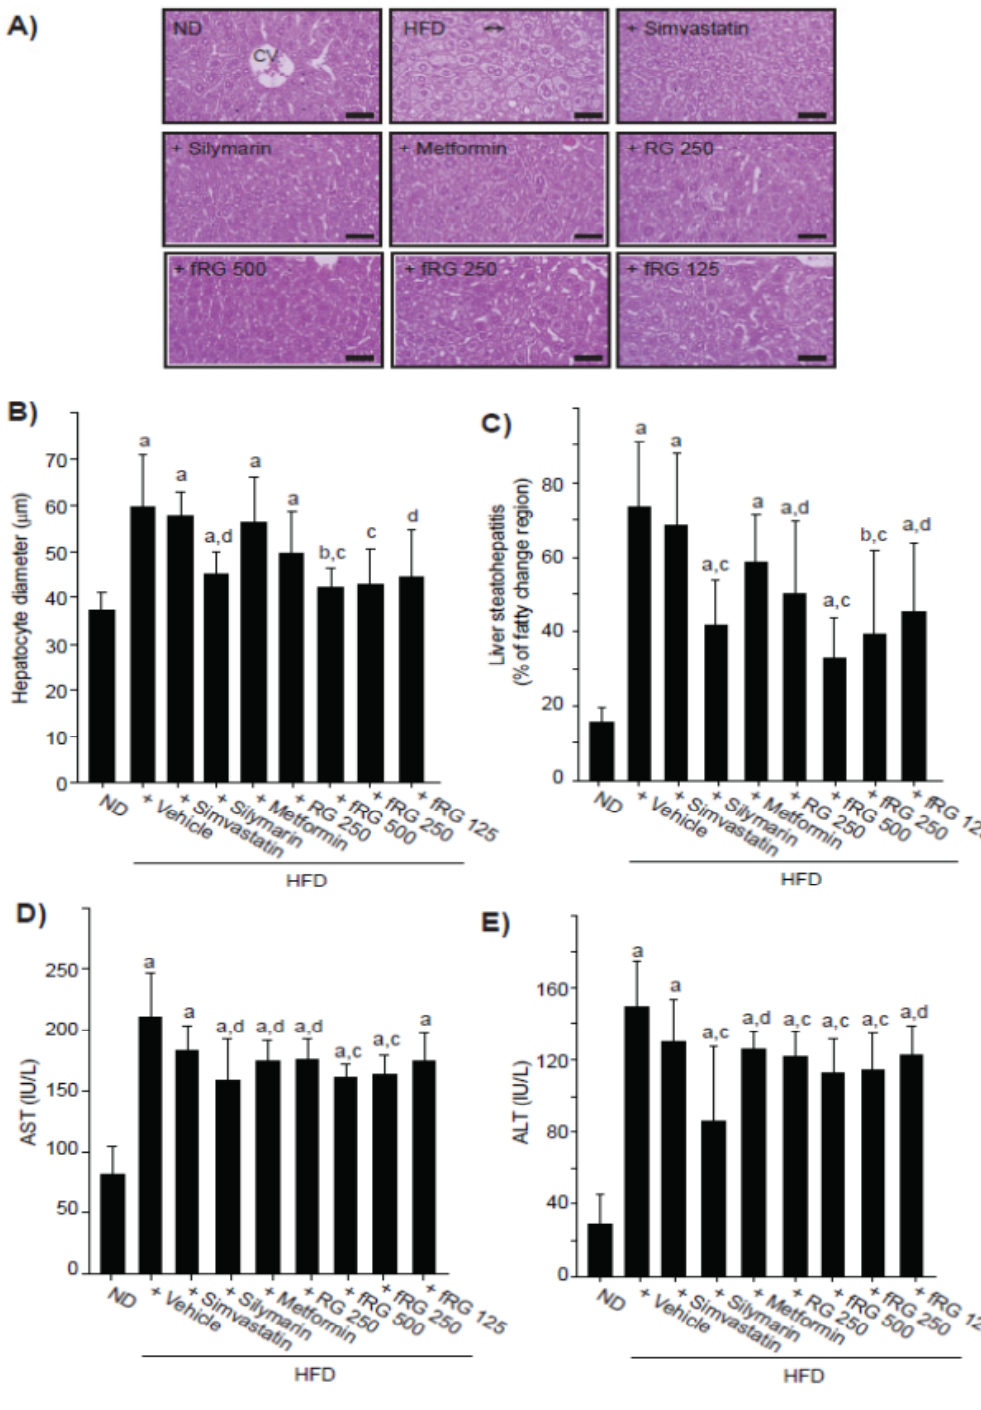
Figure 4. Effect of fRG on HFD-induced liver damages. The representative histological images of liver tissues ( A ) were stained with H & E (Scale bars = 80 μ m). The mean diameter at least 10 hepatocytes was measured using automated image analysis process ( B ). Percentage of fatty changed regions (liver steatohepatitis) was calculated in 1 mm 2 of hepatic parenchyma ( C ). The levels of AST ( D ) and ALT ( E ) were also measured as described in Figure 3. All values were expressed mean ± S.D. of eight mice (Significant as compared with ND-fed mice, a p < 0.01; b p < 0.05; significant as compared with HFD-fed mice, c p < 0.01; d p <